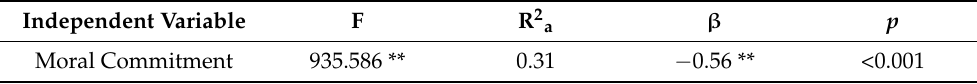
Table 4. Results of simple linear regression (H3).